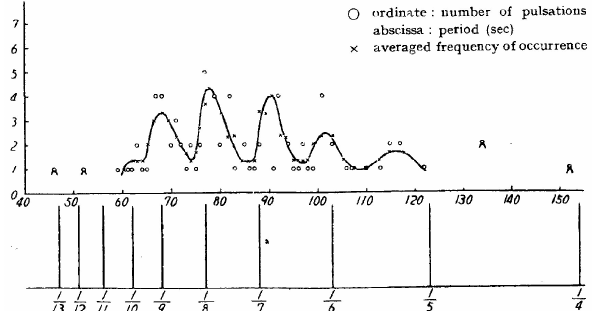
Figure 11. Harmonic structure of the spectrum of giant pulsations (Kato and Watanabe, 1954). Top: observed spectrum, and bottom: comparison with